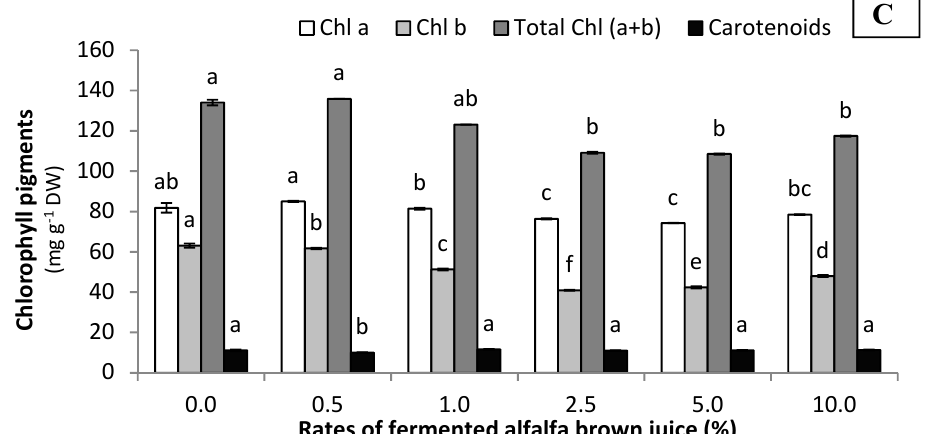
Figure 4. Water-soluble phenol ( A ), water-soluble protein ( B ), and chlorophyll pigments contents ( C ) in di ff erent plant tissues of Celosia plants sprayed at di ff erent rates of fermented alfalfa brown juice. Sample size ( n = 6). Di ff erent letters above the same columns show significant di ff erences at the level of p < 0.05.